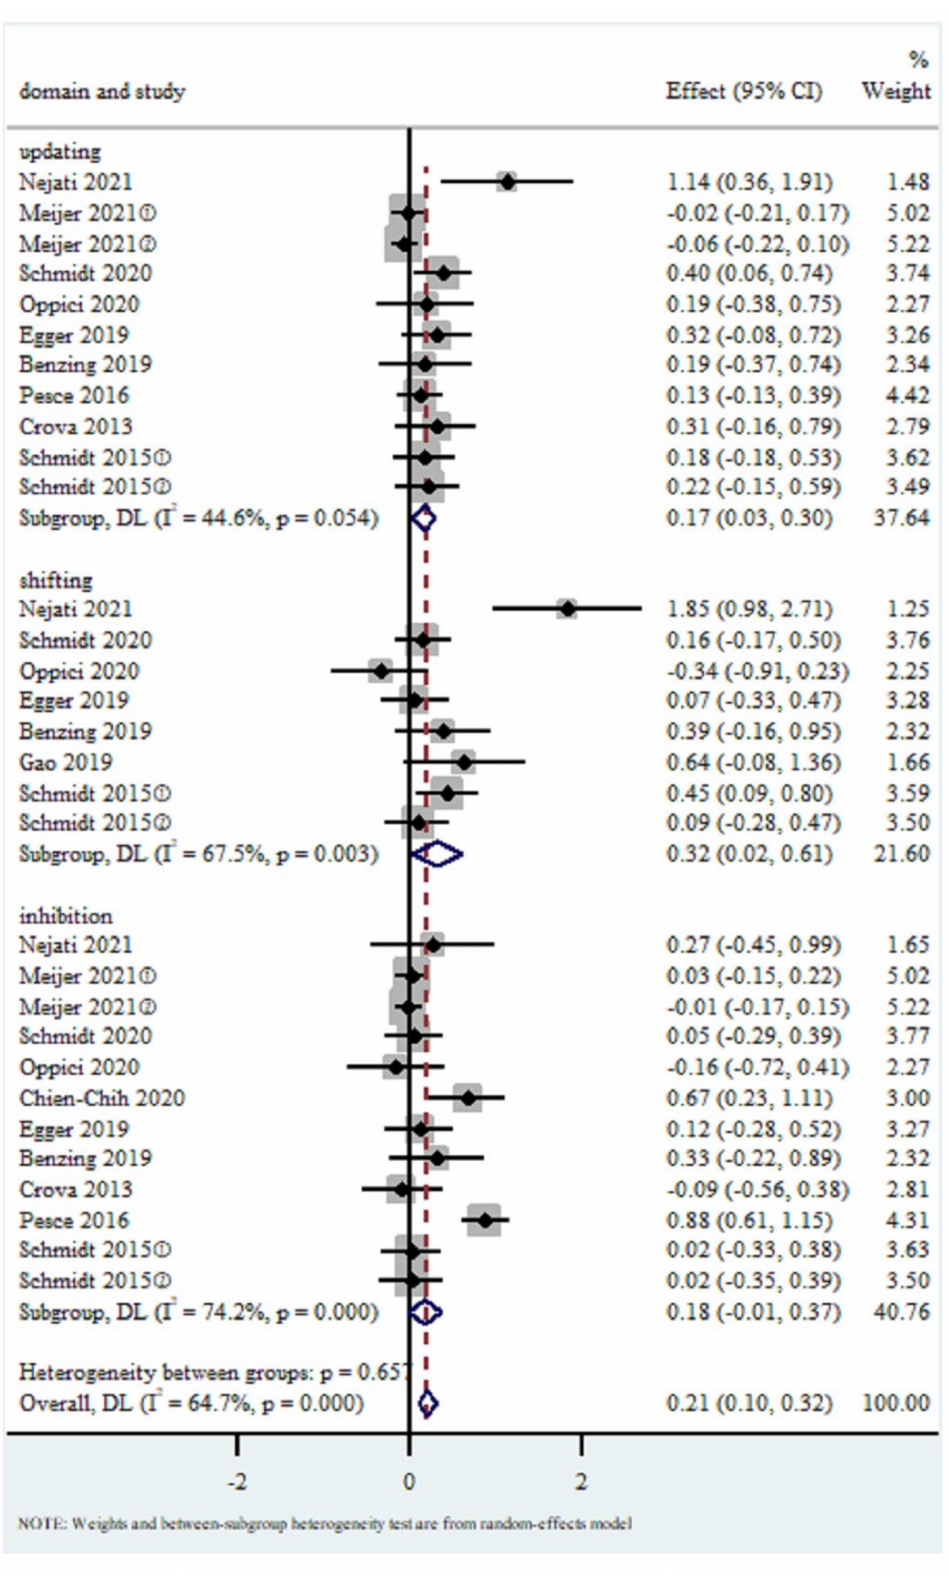
Figure 4. Forest plot for a meta-analysis of the effects of cognitively engaging PA on different EF